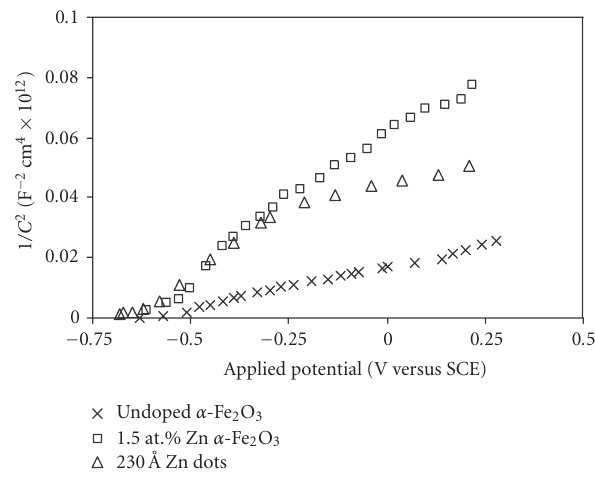
Figure 7: Mott-schottky plot under darkness in 13 pH NaOH at frequency